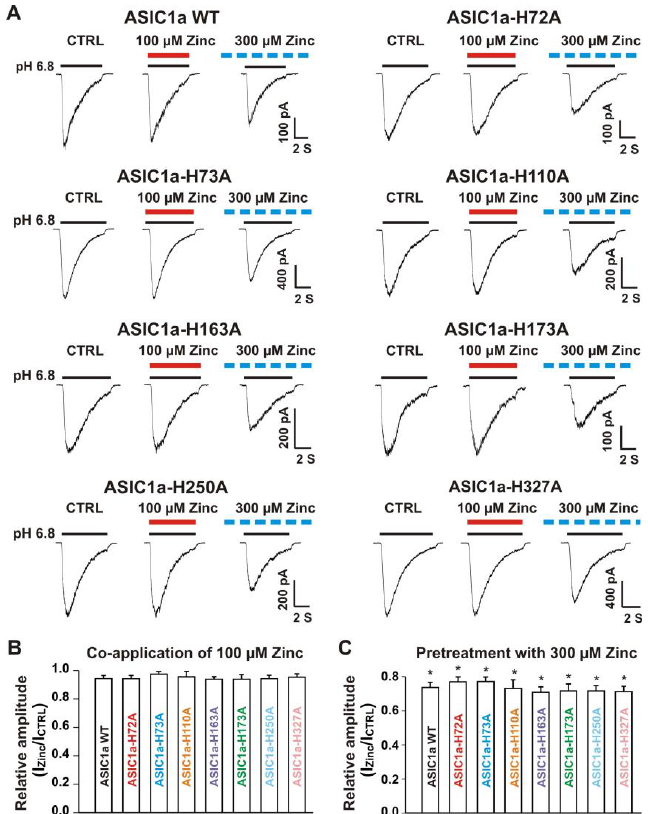
Figure 8. Zinc effects on currents from ASIC1a WT and ASIC1a mutants of histidine residues in the extracellular domain of ASIC1a. ( A ) Representative traces show that co-application of zinc at a concentration of 100 µM had no effect on peak amplitude of the currents from ASIC1a WT, ASIC1a-H72A, ASIC1a-H73A, ASIC1a-H110A, ASIC1a-H163A, ASIC1a-H173A, ASIC1a-H250A, and ASIC1a-H327A; whereas pretreatment with zinc at a concentration of 300 µM displayed an inhibitory effect on peak amplitude of the currents from ASIC1a WT, ASIC1a-H72A, ASIC1a-H73A, ASIC1a-H110A, ASIC1a-H163A, ASIC1a-H173A, ASIC1a-H250A, and ASIC1a-H327A. The solid red and black lines represent 100 µM zinc and pH 6.8 application, respectively (each recoding with 7 s of zinc and pH 6.8 application). The dashed blue line represents pretreatment with 300 µM zinc in the pH 7.4 solution with a duration of 2 min. ( B , C ) Statistical bar graphs show relative peak amplitudes of the ASIC1a/3 currents by co-application of zinc (B, n = 8 to 10) and pretreatment with zinc (C, n = 6 to 10). There was no significant difference for zinc inhibition among ASIC1a WT and their histidine mutants ( p > 0.05, ANOVA). For ASIC1a mutation, histidine residues in the extracellular domain of ASIC1a were replaced with alanine. Whole-cell patch-clap recording was performed and currents from homomeric ASIC1a WT and its histidine mutants were activated by a drop in pH from 7.4 to 6.8. Data are presented as mean ± SEM. CTRL, control. * p < 0.05 (t-test). 3.5.2. Histidine 72 and 73 in the Extracellular ASIC1a Domain Responsible for Inhibition of Next, we co-overexpressed each ASIC1a histidine mutant with homomeric ASIC3 WT in CHO cells and examined their effects on currents from ASIC1a histidine mutants co-expressed with ASIC3 WT in response to zinc. Due to co-expression, four possibilities exist. One possibility is only the expression of an ASIC1a histidine mutant, another possibility is only the expression of ASIC3